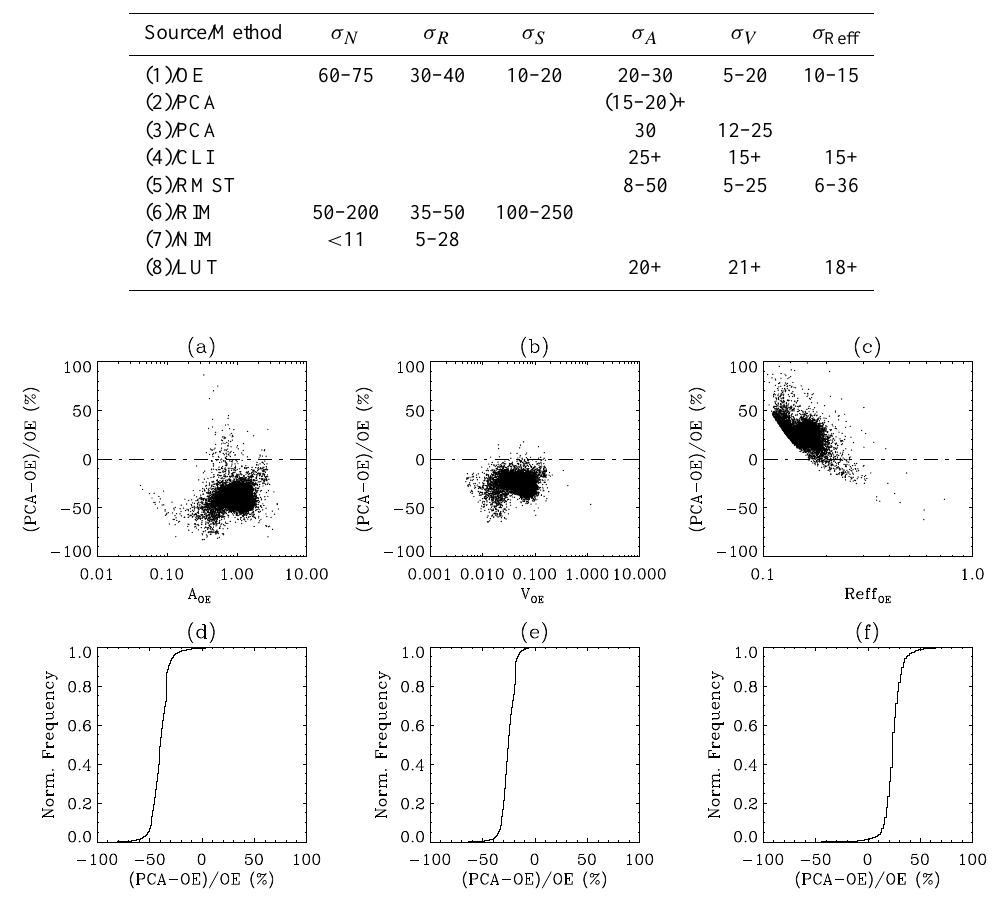
Table 7. Overview of uncertainties (in %) on aerosol properties retrieved under similar conditions (background aerosol, SAGE data) but using different retrieval techniques. The “+” indicates that the value is an estimate of partial errors only and that the total error is expected to be higher due to other disregarded uncertainty components. The uncertainties in A as reported by Steele et al. (1999) and Steele and Turco (1997), for instance, account for propagated random errors only. The total errors are expected to be higher by about 50% due to disregarded systematic (method bias) errors and contributions from particles smaller than 0 . 1µm. The methods and the conditions under which these uncertainties were achieved are described in: (1) Wurl (2008), (2) Steele et al. (1999), (3) Thomason and Poole (1993), (4) Steele and Turco (1997), (5) Anderson et al. (2000), (6) Bingen et al. (2004b), (7) Wang et al. (1989), and (8) Bauman et al. (2003a). The acronyms stand for Principal Component Analysis (PCA), Constrained Linear Inversion (CLI), Randomized Minimization Search Technique (RMST), Regularized Inversion Method (RIM), Nonlinear Iterative Method (NIM), and Look-Up-Table approach (LUT).